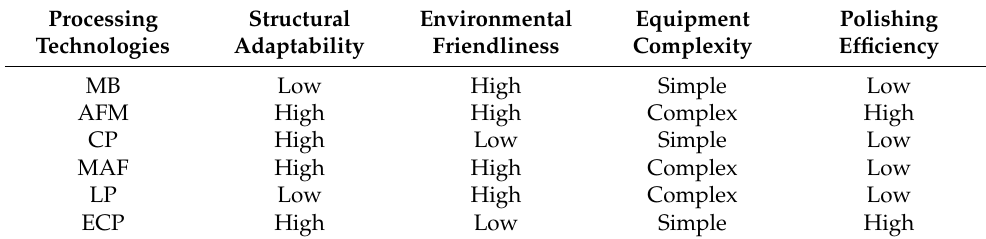
Table 1. Comparison of different polishing